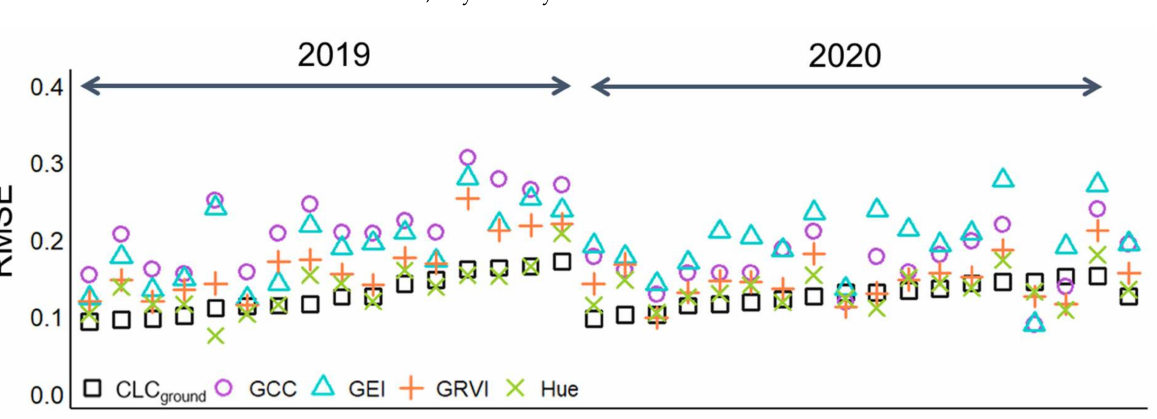
Figure 4. Seasonal trajectories of daytime total sap flux density (SFD day ) and optimized sap flux density (SFD opt ) derived from Equations (6) and (7) ( A , B ) with daily total solar radiation ( R s_day ) and daytime mean vapor pressure deficit (VPD day ) ( C , D ) and SFD day response to the environmental drivers ( E , F ) for Betula grossa Siebold & Zucc. tree. Values of SFD day and SFD opt are normalized to the scale from 0 to 1. The data of SFD day and SFD opt for other individuals is shown in Figure A3. Abbreviation: DOY, day of the